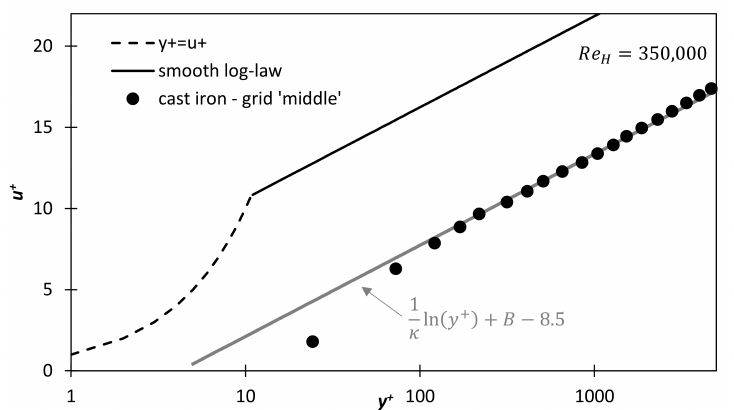
Figure 19. Dimensionless velocity profile for the DPM simulation with cast iron roughness at Re = 350,000. For the determination of the log-law in the roughness regime by Equation (2), the constants κ = 0.41 and B = 5.0 were used. The downshift was identified as ∆ u + =